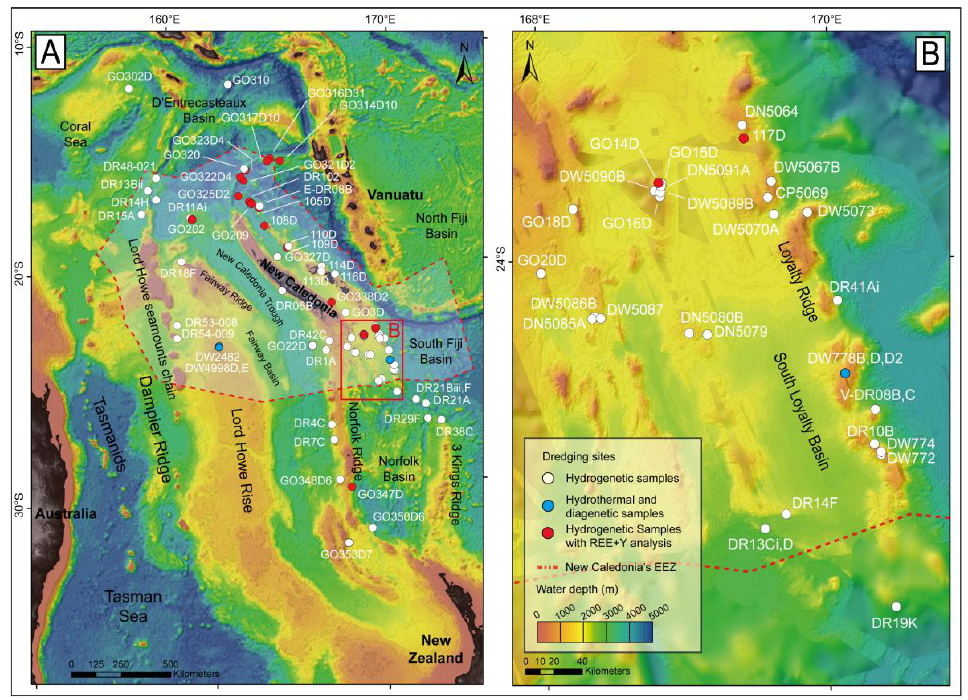
Figure 2. ( A ) Bathymetric map of the South-West Pacific; ( B ) Bathymetric map of southern New Caledonia.